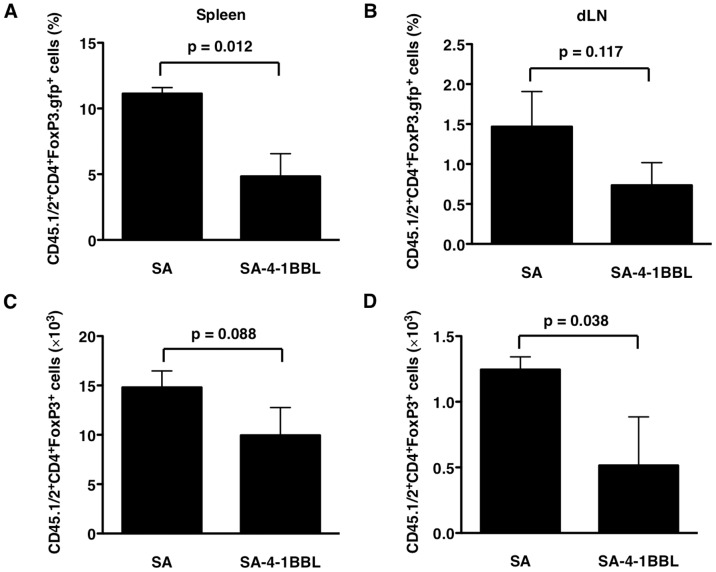
SA-4-1BBL blocks intratumoral conversion of CD4+FoxP3.gfp− T cells into CD4+FoxP3.gfp+ T cells.C57BL/6.SJL (CD45.1) mice were challenged s.c. in the right flank with 2.5×106 live OVA expressing EG.7 (CD45.2) tumor cells. (A and B) Sorted OT.II CD4+FoxP3.gfp− T cells (CD45.1/2) were injected intratumorally into tumor (9–10 mm in diameter) bearing C57BL/6.SJL (CD45.1) mice followed by intratumoral injection with SA-4-1BBL (25 µg) or an equimolar (10 µg) SA control protein one day later. The percentages (A, B) and absolute numbers (C, D) of CD45.1/2+CD4+FoxP3.gfp+ T cells in the spleen and draining LNs were assessed 5 days post treatment with SA-4-1BBL. (E) Absolute number of CD45.1/2+CD4+FoxP3.gfp+ T cells in the tumor tissues as assessed by flow cytometry. Data are representative of two independent experiments with at least 3 animals per group per experiment. (F) Confocal microscopic images of tumor tissues (100 µm upper and 50 µm lower panels) showing intracellular gfp (FoxP3, green) and cell nuclei (DAPI; blue). Tumor tissues from mice without OT.II CD4+FoxP3.gfp− T cell injection served as negative control for gfp signal. (G) Shows absolute number of cells (mean ± SEM) counted from confocal images of more than three areas/sample from three samples/group. P value was determined using Student’s t test.